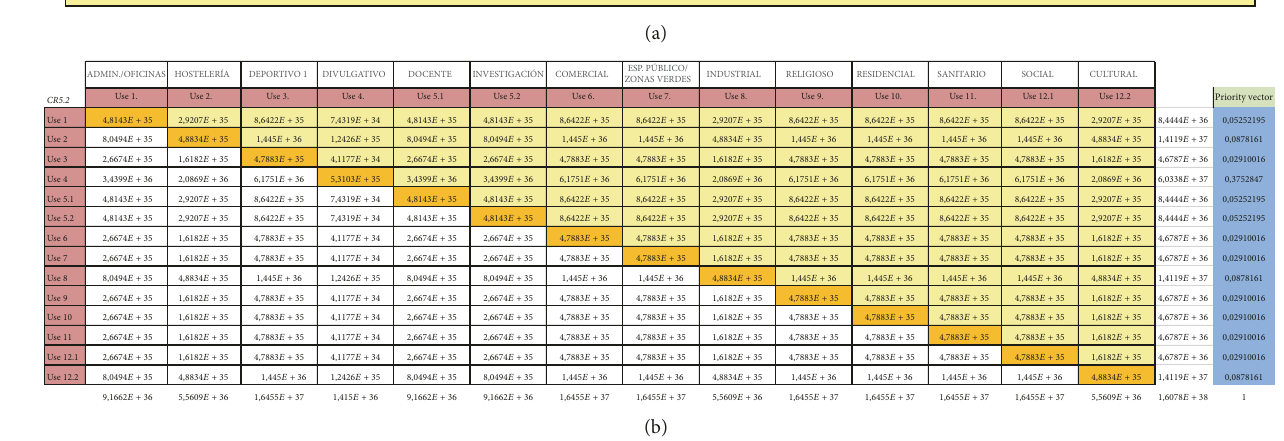
Figure 4: Formulation of the cells of the matrices in Excel.